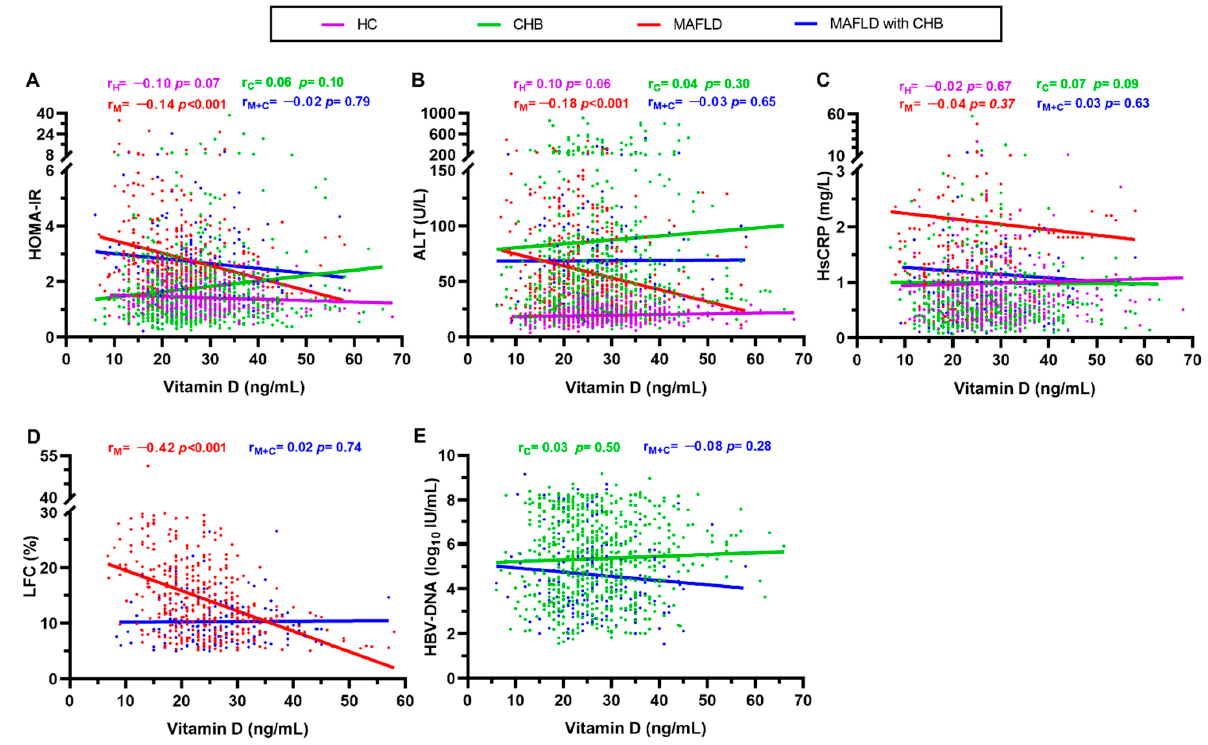
Figure 1. Distribution and correlation between VitD and other clinical parameters. ( A ) Correlation of serum VitD level with homeostasis model assessment of insulin resistance (HOMA-IR) in all four groups. ( B ) Correlation of serum VitD level with alanine aminotransferase (ALT) in all four groups. ( C ) Correlation of serum VitD level with hypersensitive C-reactive protein (Hs-CRP) in all four groups. ( D ) Correlation of serum VitD level with liver fat content (LFC) in the MAFLD and MAFLD with CHB groups. ( E ) Correlation of serum VitD level with hepatitis B virus (HBV) viral load in CHB and MAFLD with CHB groups. HC, healthy control; CHB, chronic hepatitis B; MAFLD, metabolic-associated fatty liver disease; VitD, vitamin D. r H , r C , r M and r M+C represent the correlation coefficients in the healthy controls (HC), CHB, MAFLD and MAFLD with CHB groups, respectively.